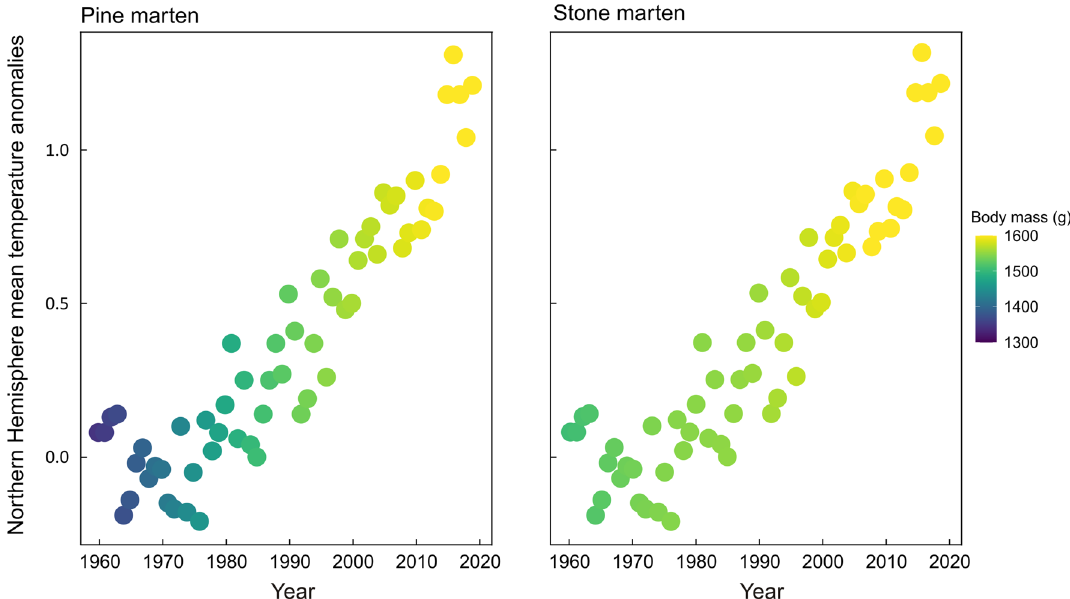
Figure 2. Northern Hemisphere mean temperature anomalies since 1960 and annual mean body mass of pine and stone marten males in Europe. Body mass changes are indicated by colour